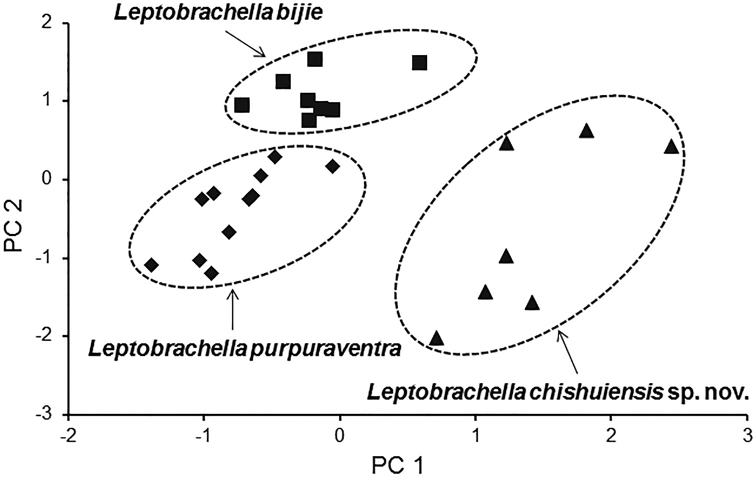
Plots of the first principal component (PC1) versus the second (PC2) for Leptobrachella
chishuiensis sp. nov., L.
bijie, and L.
purpuraventra in males from a principal component analysis.